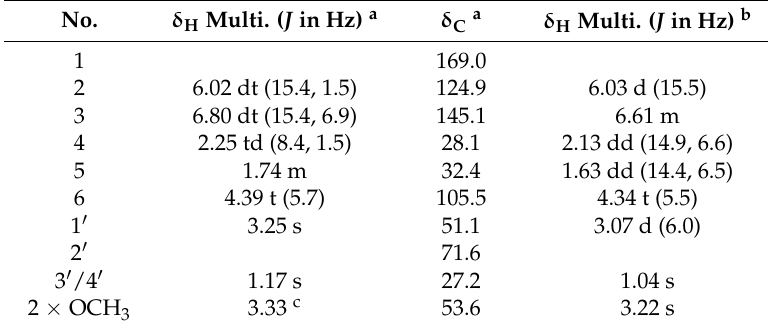
Table 2. 1 H- (500 MHz) and 13 C- (125 MHz) NMR Data of Compound 4 ( δ ppm).